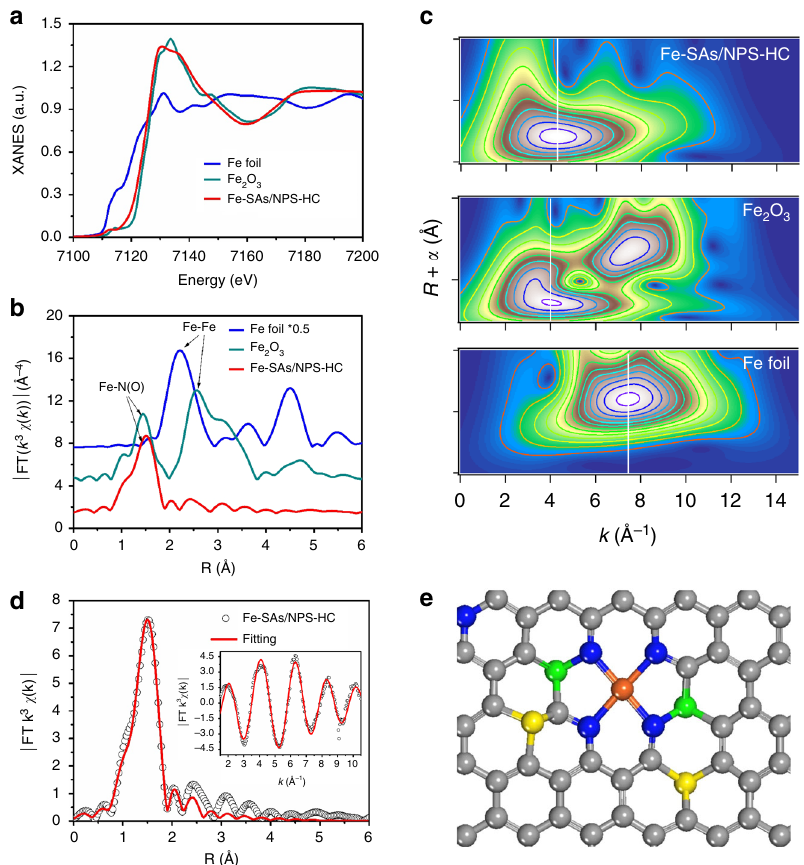
Fig. 3 Atomic structural analysis. a , b Fe K -edge X-ray absorption near-edge structure (XANES) spectra ( a ) and Fe K -edge k 3 -weighted Fourier transform (FT) spectra ( b ) of single iron atomic sites supported on a nitrogen, phosphorus and sulfur co-doped hollow carbon polyhedron (Fe-SAs/NPS-HC), Fe 2 O 3 and Fe foil samples, respectively. c Wavelet transform (WT) of Fe-SAs/NPS-HC in comparison with Fe 2 O 3 and Fe foil samples, respectively. d The corresponding extended X-ray absorption fi ne structure (EXAFS) R space fi tting curves; inset: The corresponding EXAFS k space fi tting curves of Fe-SAs/ NPS-HC. e Schematic model of Fe-SAs/NPS-HC, Fe (orange), N (blue), P (green), S (yellow) and C